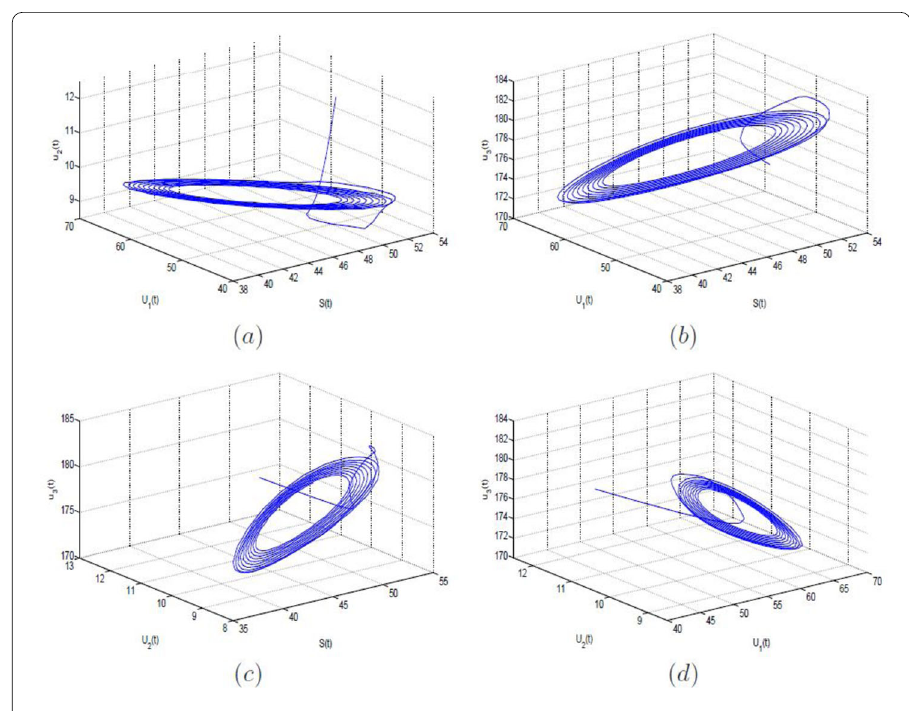
Figure 4 Phase portrait of system (15) with τ = 45.25 > τ 0 = 40.1285: ( a ) S – U 1 – U 2 , ( b ) S – U 1 – U 3 , ( c ) S – U